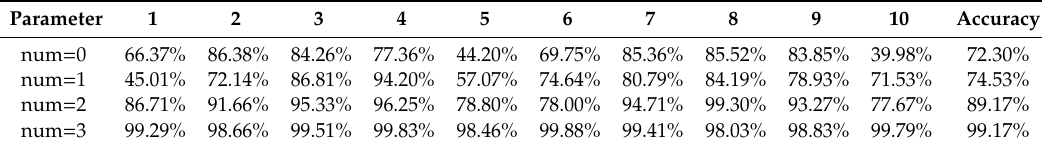
Table 2. 10-fold cross-validation